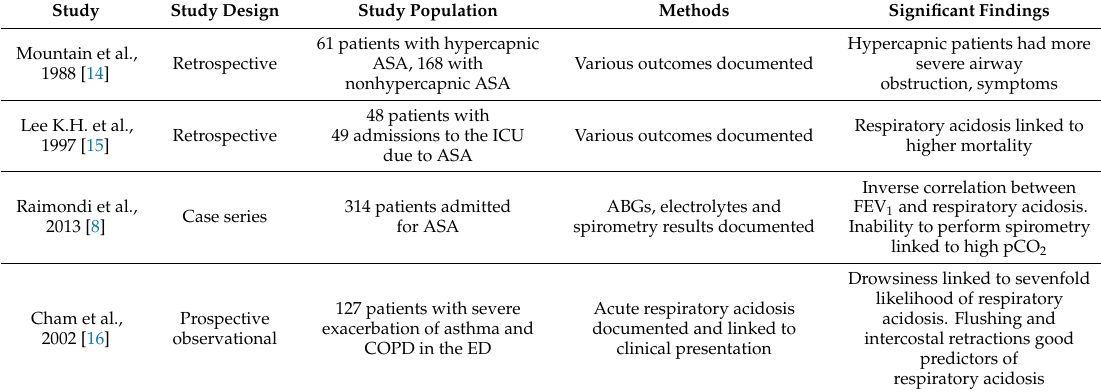
Table 2. Respiratory